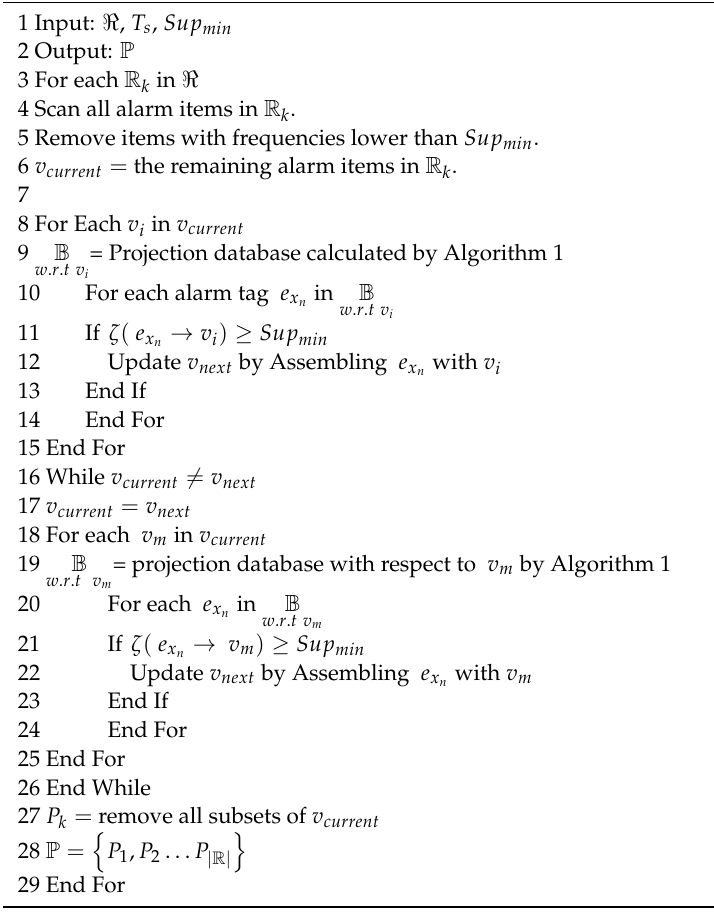
Algorithm 2 Major codes for discovering closed frequent alarm patterns in